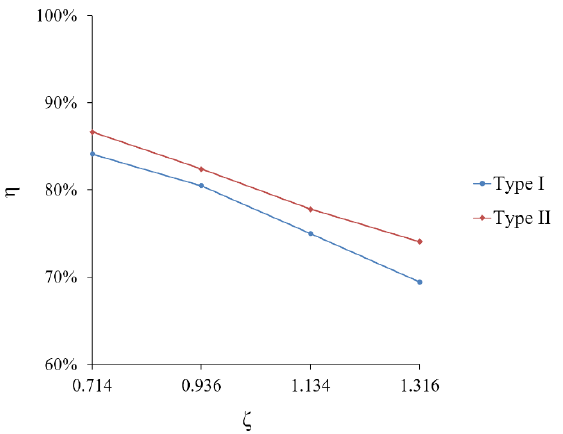
Figure 15. Energy dissipation rate of two types of step